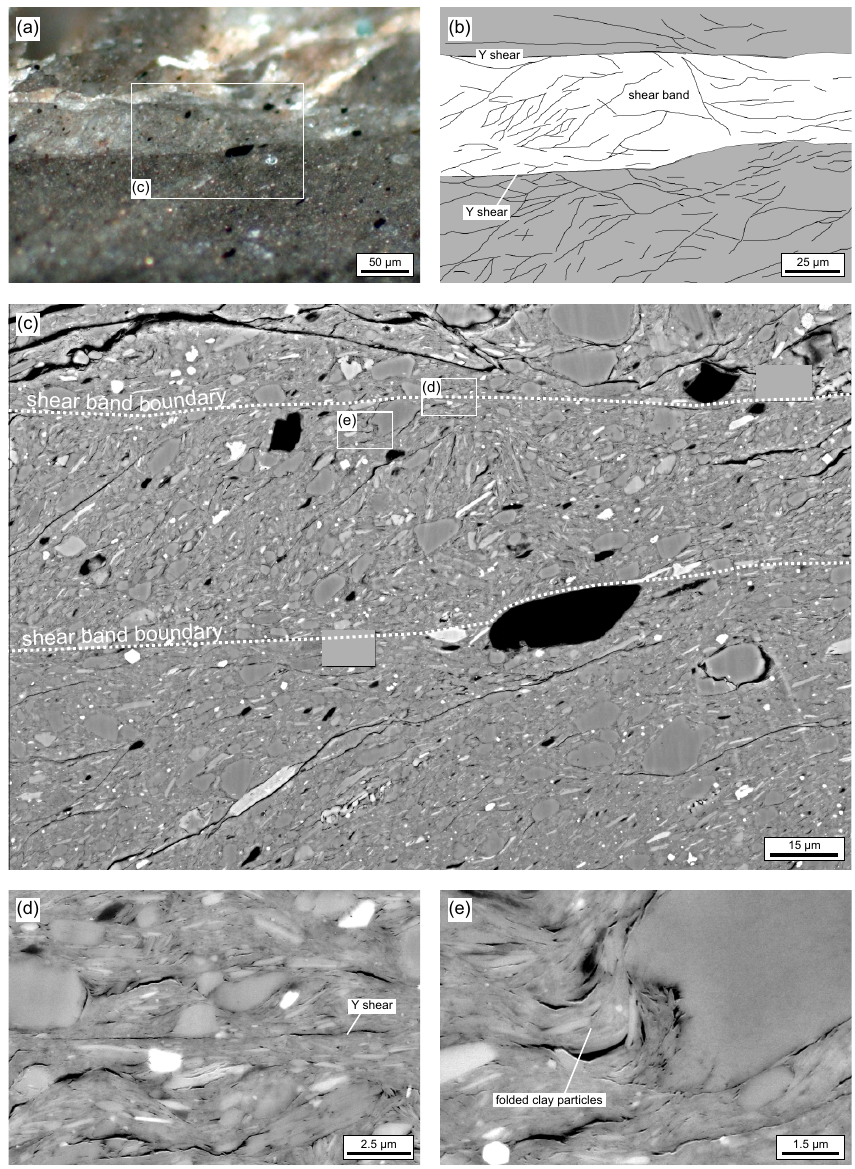
Figure 10. Microstructures of a gouge-internal shear band (sample A1-1) with micrometer-thin Y-shear boundaries (d) , strained organic matter (dark grains) and pores in pressure shadow regions of larger grains (e) . (a) Reflected light micrograph and (b) sketch of foliations. (c, d, e) BIB-SEM (BSE) micrographs. The shear band is located at the border of gouge with vein-enriched scaly wall rock. See Fig. 5c for